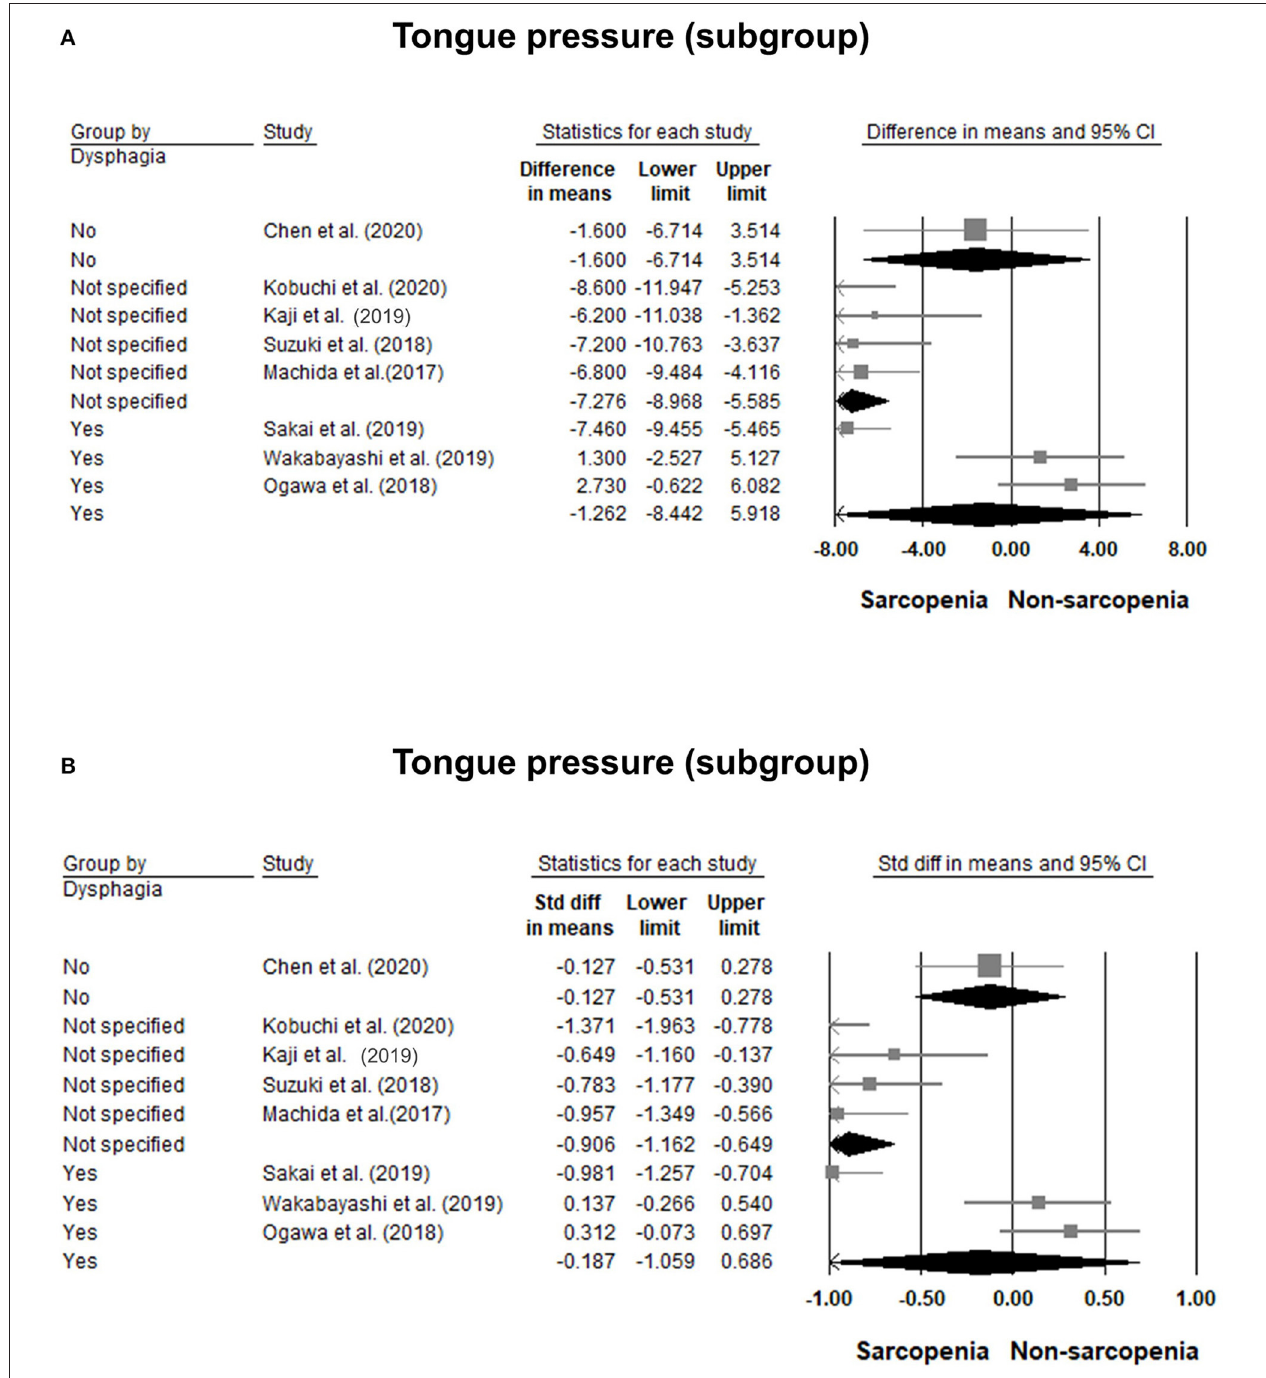
FIGURE 3 | Forest plot of the subgroup analysis of the tongue pressure based on the presence of dysphagia quantified by the weight mean difference (A) and standardized mean differences (B) .